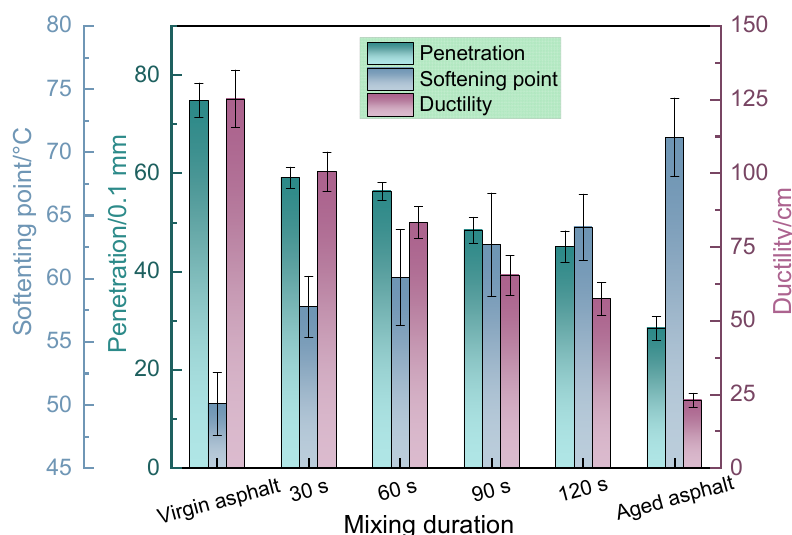
Figure 7. Test results for physical properties of asphalt binder.